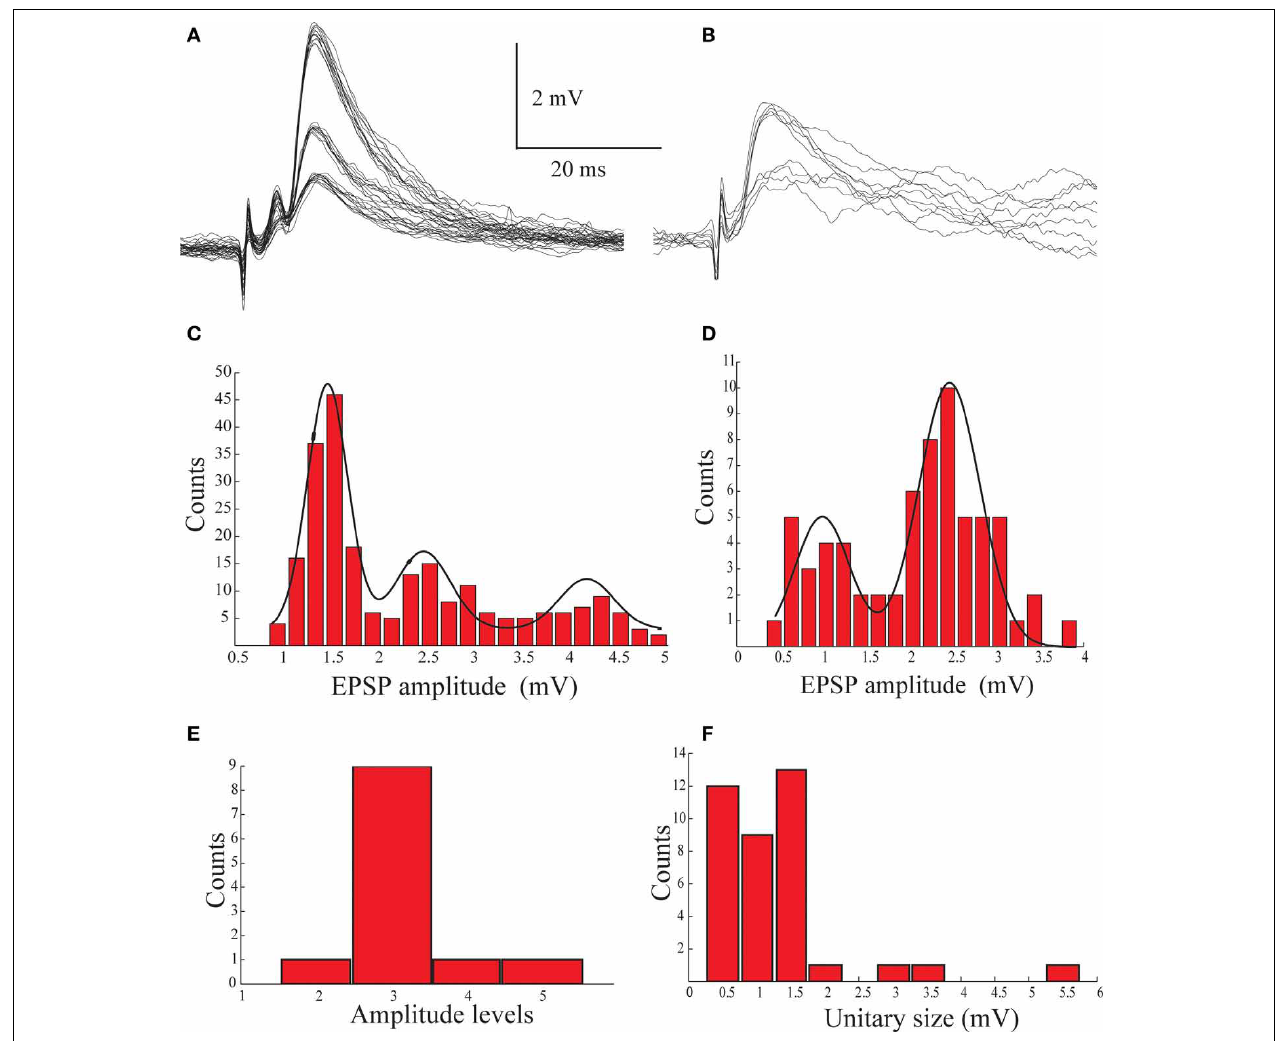
FIGURE 4 | The multimodal distribution of the synaptic potentials evoked by afferent nerve stimulation. (A,B) An example of synaptic potentials recorded from two AENs following gradual increase in stimulation intensity of the afferent nerve. (C,D) Histograms of the amplitude distribution of the traces shown in